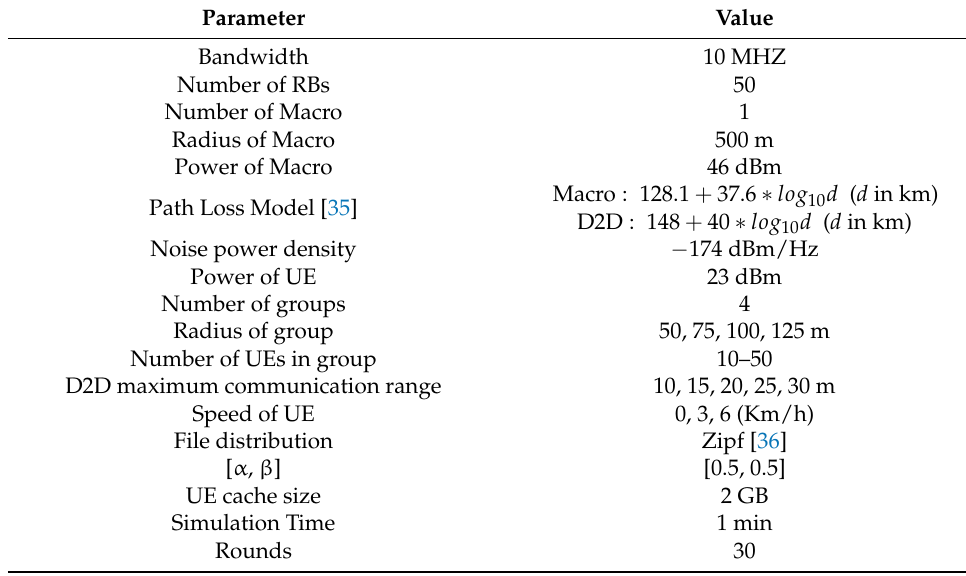
Figure 10. A scenario for the simulations. Table 1. Environmental and parameter settings for